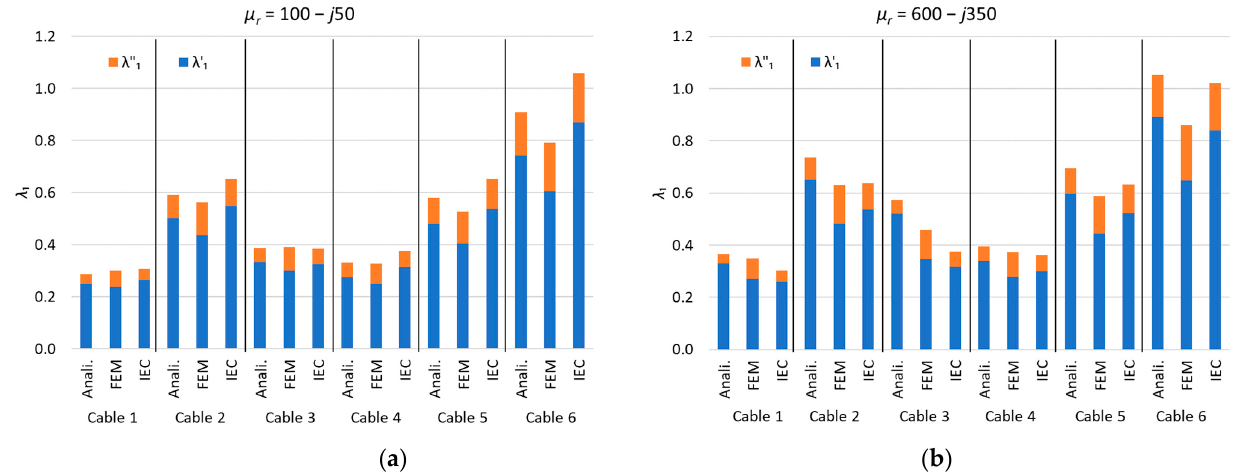
Figure 15. Circulating, eddy and total losses for the 6 cables with ( a ) µ r = 100 − j 50 and ( b ) µ r = 600 − j 350 derived by 3D-FEM simulations and the analytical expressions presented in [5,6].